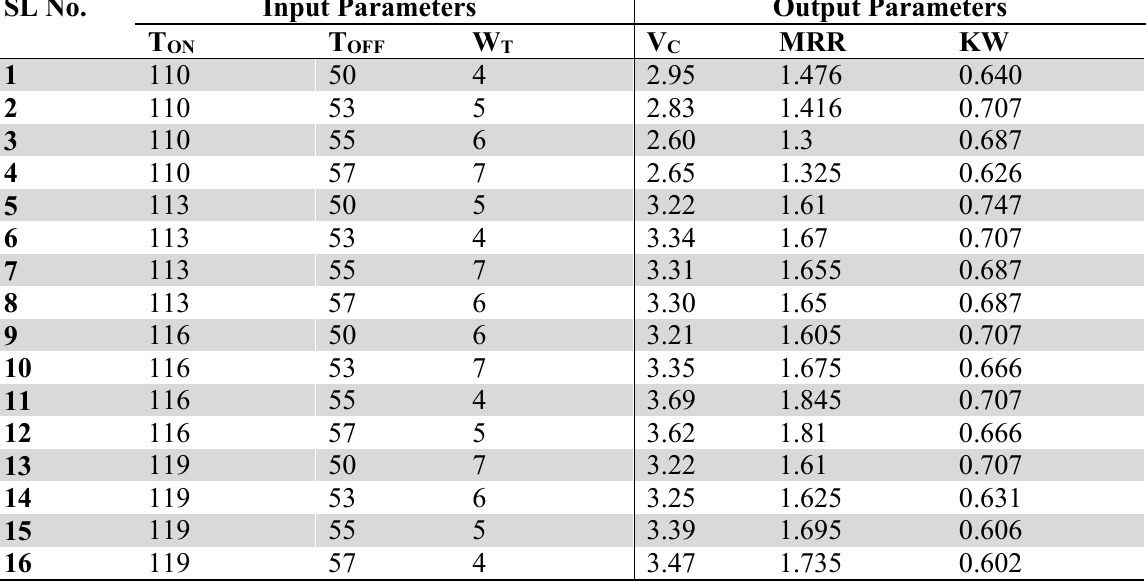
Design of experiments using L16 array SL